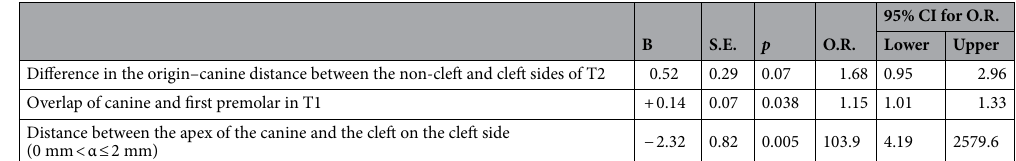
Table 7. Multivariate logistic regression analysis. B estimate, S.E. standard error, p p-value, O.R. odds ratio, 95% CI for O.R. 95% confidence interval for odds ratio.